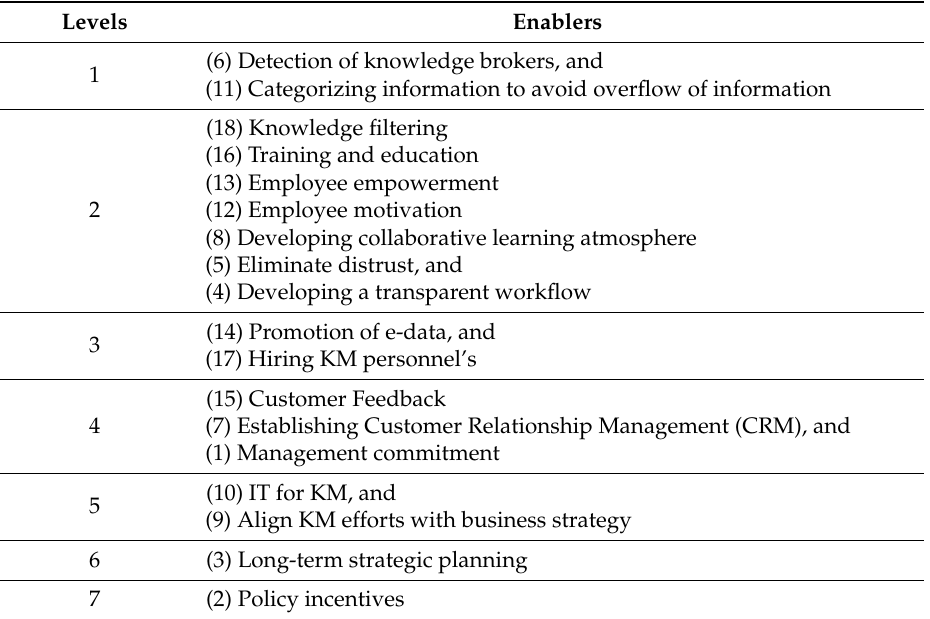
Table 13. Different levels of barriers to knowledge management implementation in the healthcare sector of Pakistan. Knowledge Management